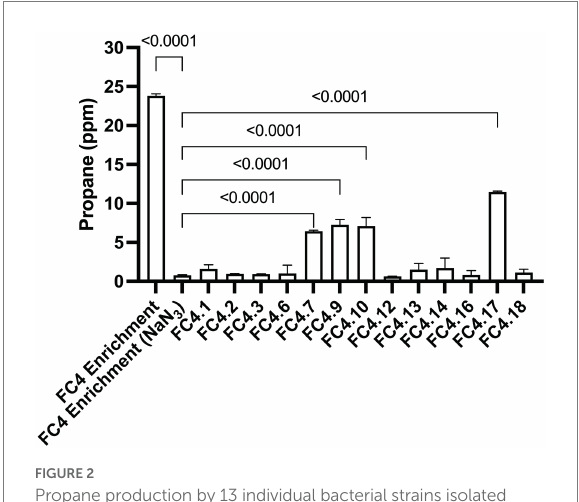
FIGURE 2 Propane production by 13 individual bacterial strains isolated from enrichment cultures generated from marine sediment samples. Following growth at 4 ° C for 8 weeks significantly higher levels of propane was detected in strains FC4.7, FC4.9, FC4.10 and FC4.17 in comparison to NaN 3 treated control samples. One- way ANOVA with Dunnett’s post hoc test ( p ≤ 0.05, n = 3).